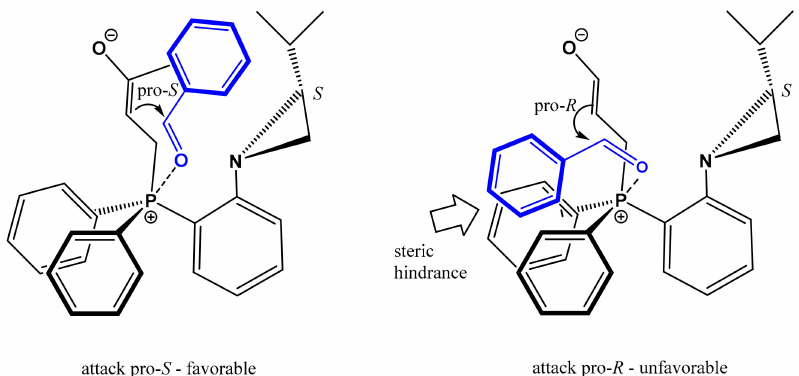
Figure 2. Proposed transition state